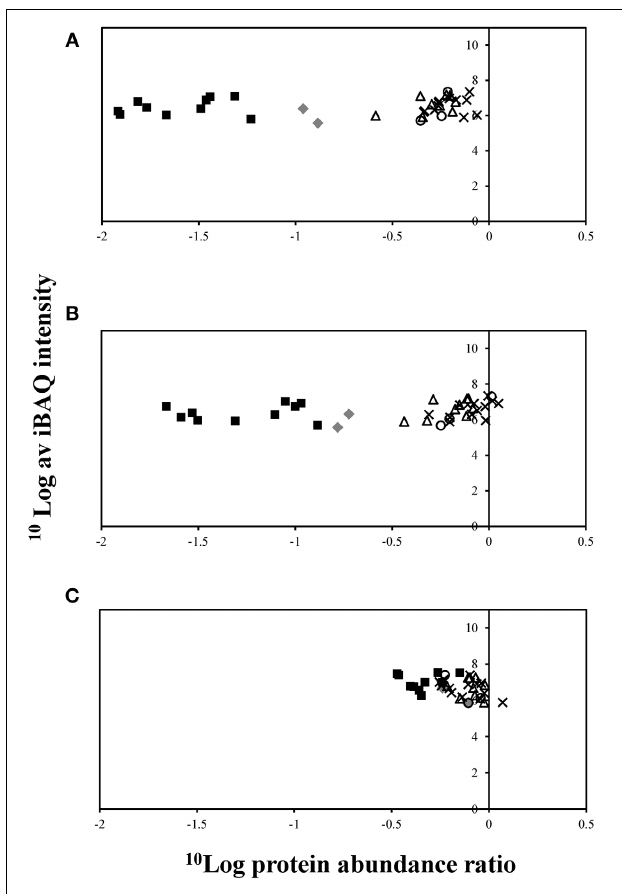
FIGURE 5 | Proteins associated with corrinoid biosynthesis and uptake, extracted from D. restrictus cells cultivated in the presence of different cyanocobalamin concentrations. (A) Proteomics analysis of cells cultivated in the presence of high (250 μ g/L) vs. low (10 μ g/L) corrinoid concentrations; (B) high (250 μ g/L) vs. mid (50 μ g/L) corrinoid concentrations; (C) mid (50 μ g/L) vs. low (10 μ g/L) corrinoid concentrations. Proteins encoded by corrinoid operon-1 (gray diamonds), operon-2 (black squares), operon-3 (white triangles), operon-4 (white circles), and operon-5 (black crosses) are shown. Logarithmic average of iBAQ (Intensity based absolute quantitation) value is plotted against the log value of protein abundance ratio based on LFQ value. CbiM (Dehre_0278) was left out because it could not be identified in two replicates of cultures under low corrinoid